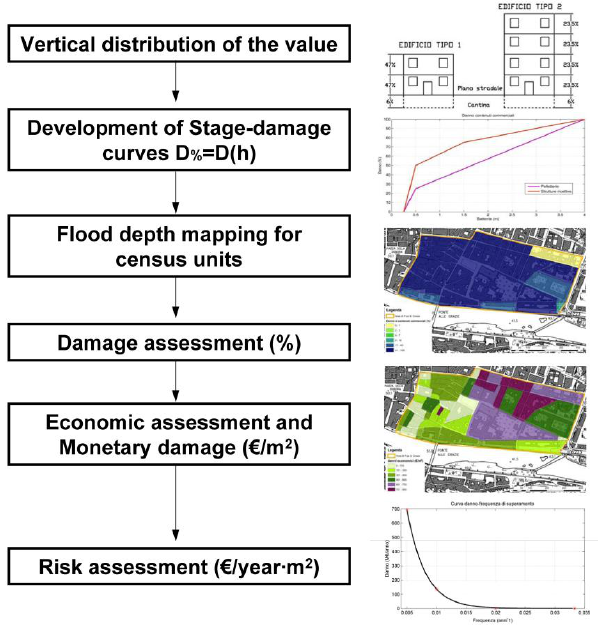
Figure 3. Risk assessment procedure based on census section scale. 2 Fig. 3. Risk assessment procedure based on census section